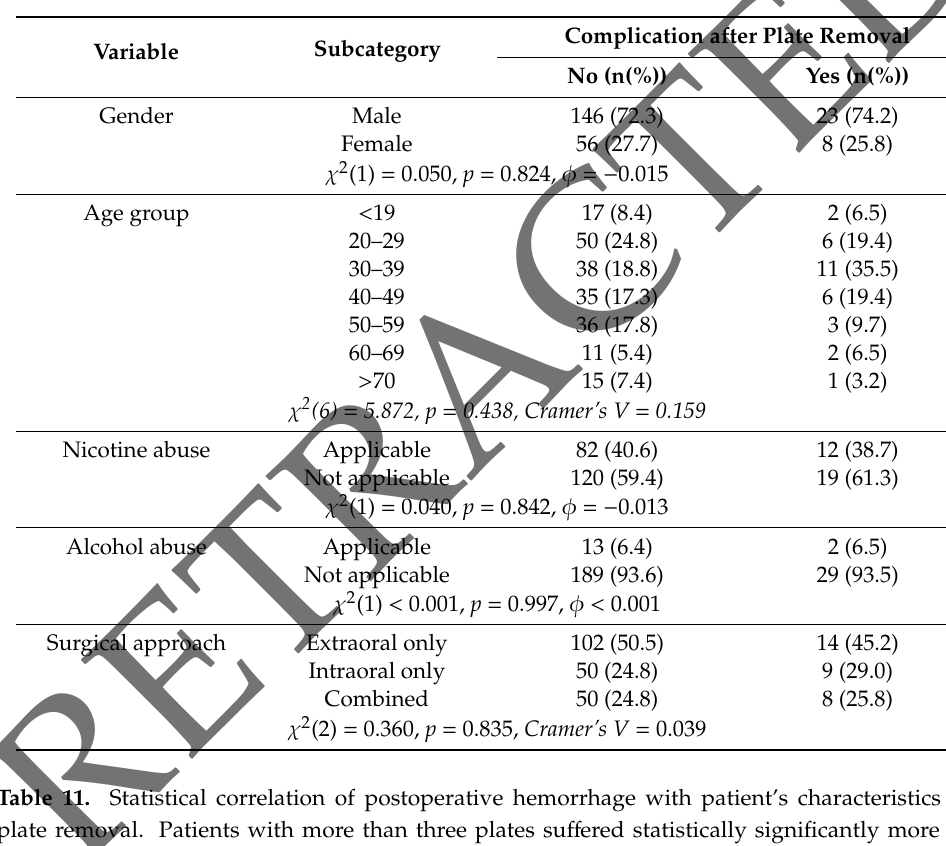
Table 10. Complications after plate removal in correlation to patient’s characteristics. All results were calculated by Pearson’s Chi-square test. The calculation of the correlation of the age group had more degrees of freedom. The result of this Chi-square test might not be as powerful as the other results. Totals of the percentages may not be exactly 100% because of rounding.